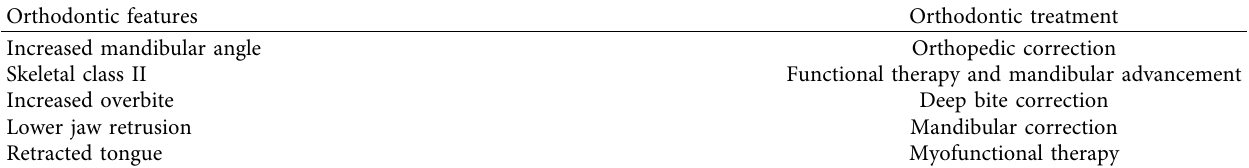
Table 2: Greater orthodontic issues and goals in pediatric population OSAS